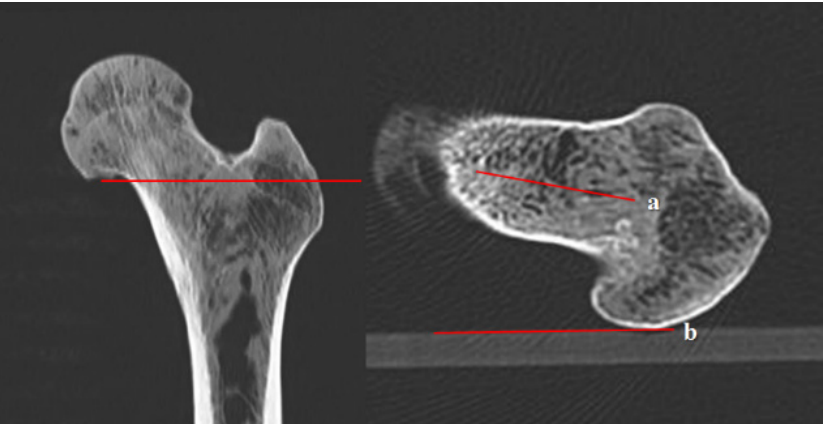
Figure 6. Left image: Femoral anteversion angle (angle between a and b) using the B line on the transverse section of a single transverse sectional image at the level of the mid-portion of the basal neck (left image). Right image: (a) the midline of the basal neck of the femur on the transverse section; (b) the connecting line of the posterior border of both femoral condyles.